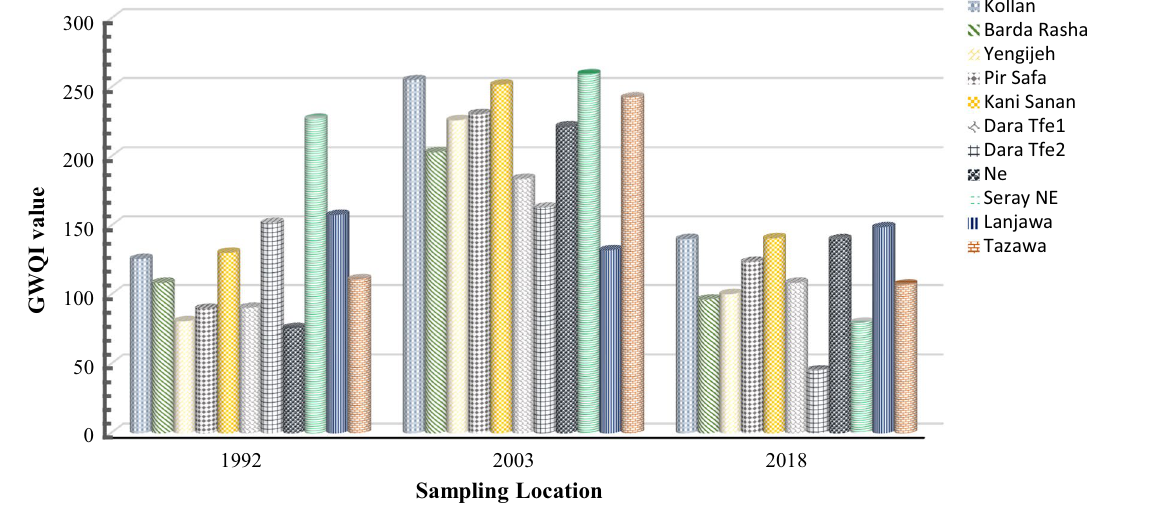
Fig. 11 The chart GWQI index in